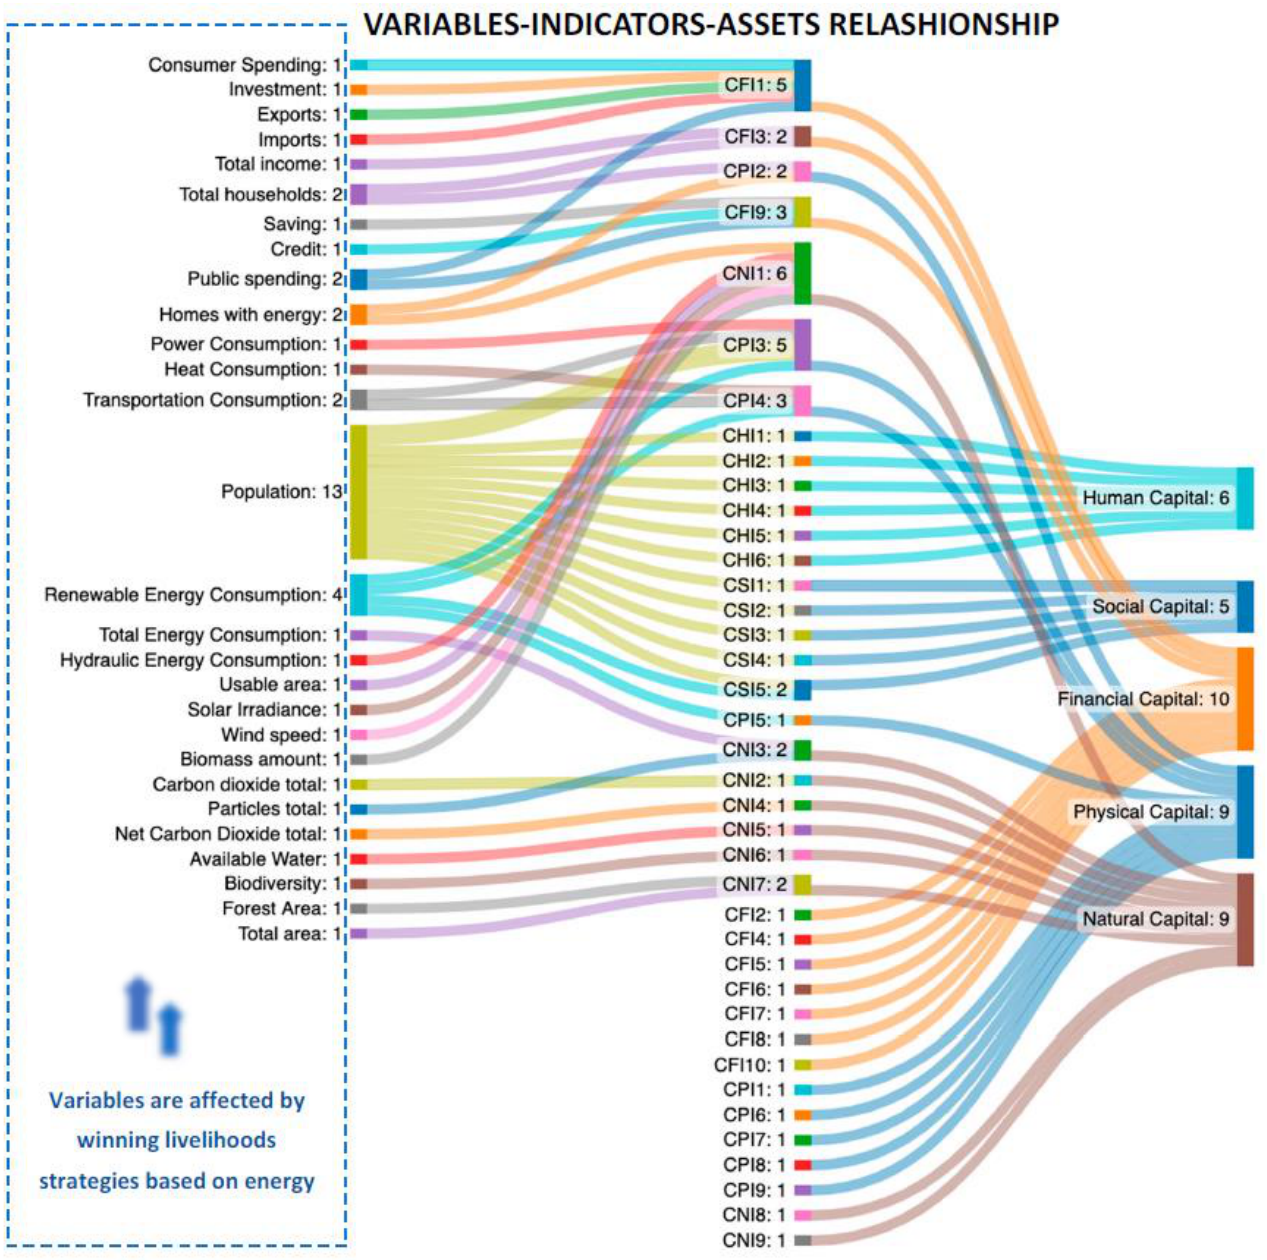
Figure 5. Variables indicators assets relationship diagram.